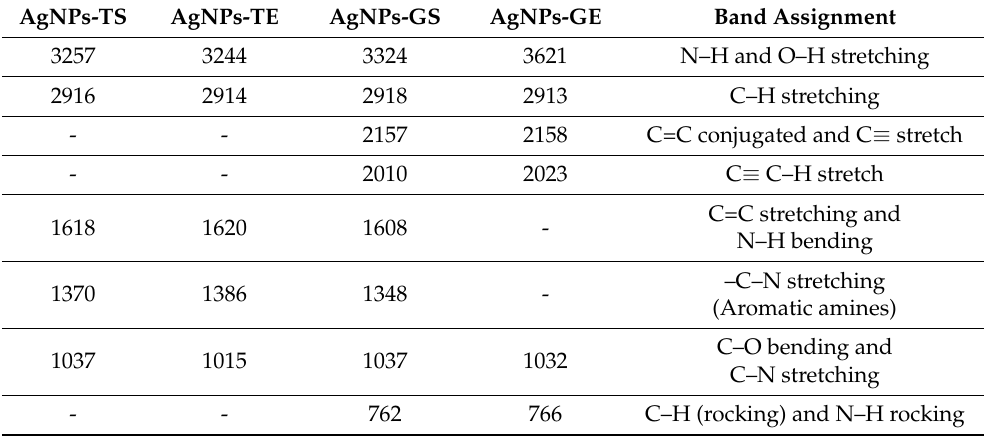
Table 2. FTIR spectrum absorption bands and the corresponding functional groups involved in the synthesis of AgNPs.